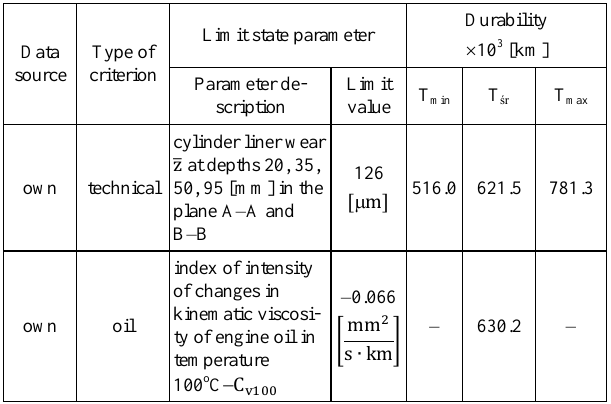
Table 1. Comparison of forecasts of cylinder liners durability of the 359M